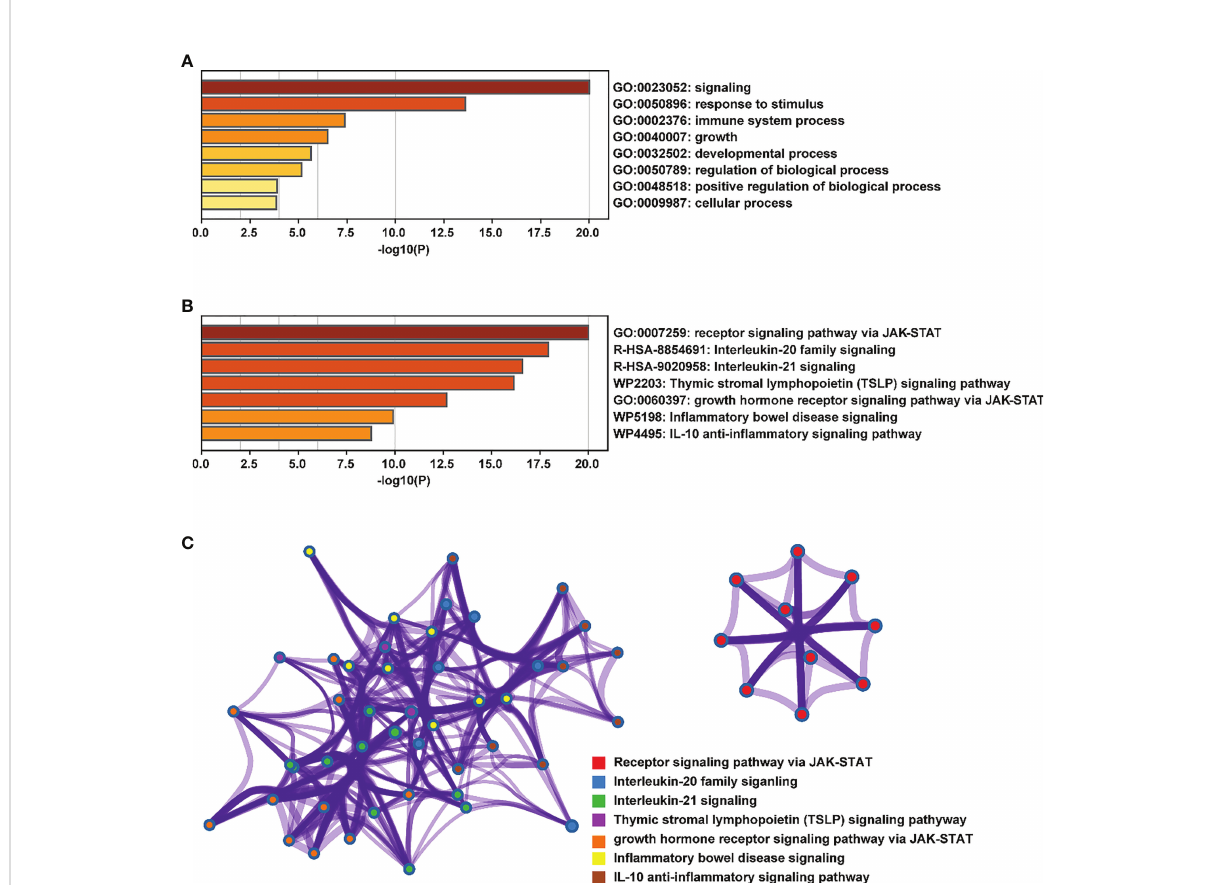
FIGURE 2 Enrichment analysis of the main functions of the STAT family. (A, B) biological processes and pathways related to STATs genes as enriched in Gene Ontology, colored by p -values. (C) An enrichment network: each node in a cluster is colored accordingly, with cluster IDs that are close together being